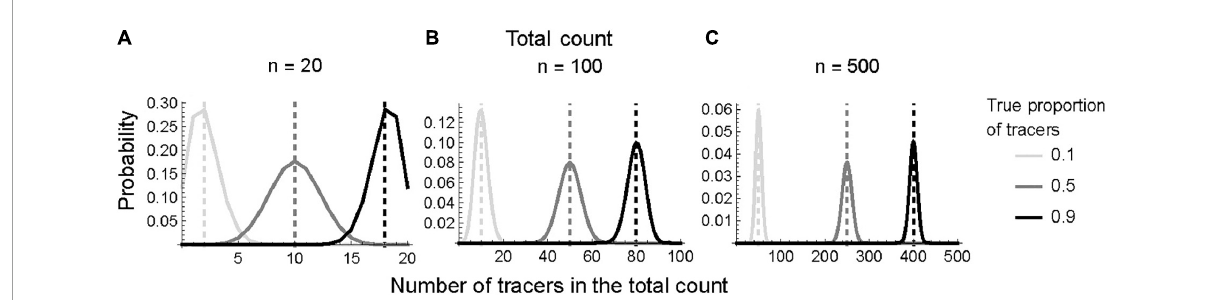
FIGURE1 Hypergeometric distribution as a function of tracer frequency and total count. Panels show the probability (Y–axis) of obtaining a number of tracers in the sample (X-axis) at (A) low, n = 20; (B) moderate, n = 100; and (C) high, n = 500, total counts in panels (A–C) . The dashed vertical line denotes the true proportion of spore in the sample. For each case, 10,000 tracers were added. Note the different Y axis scales.